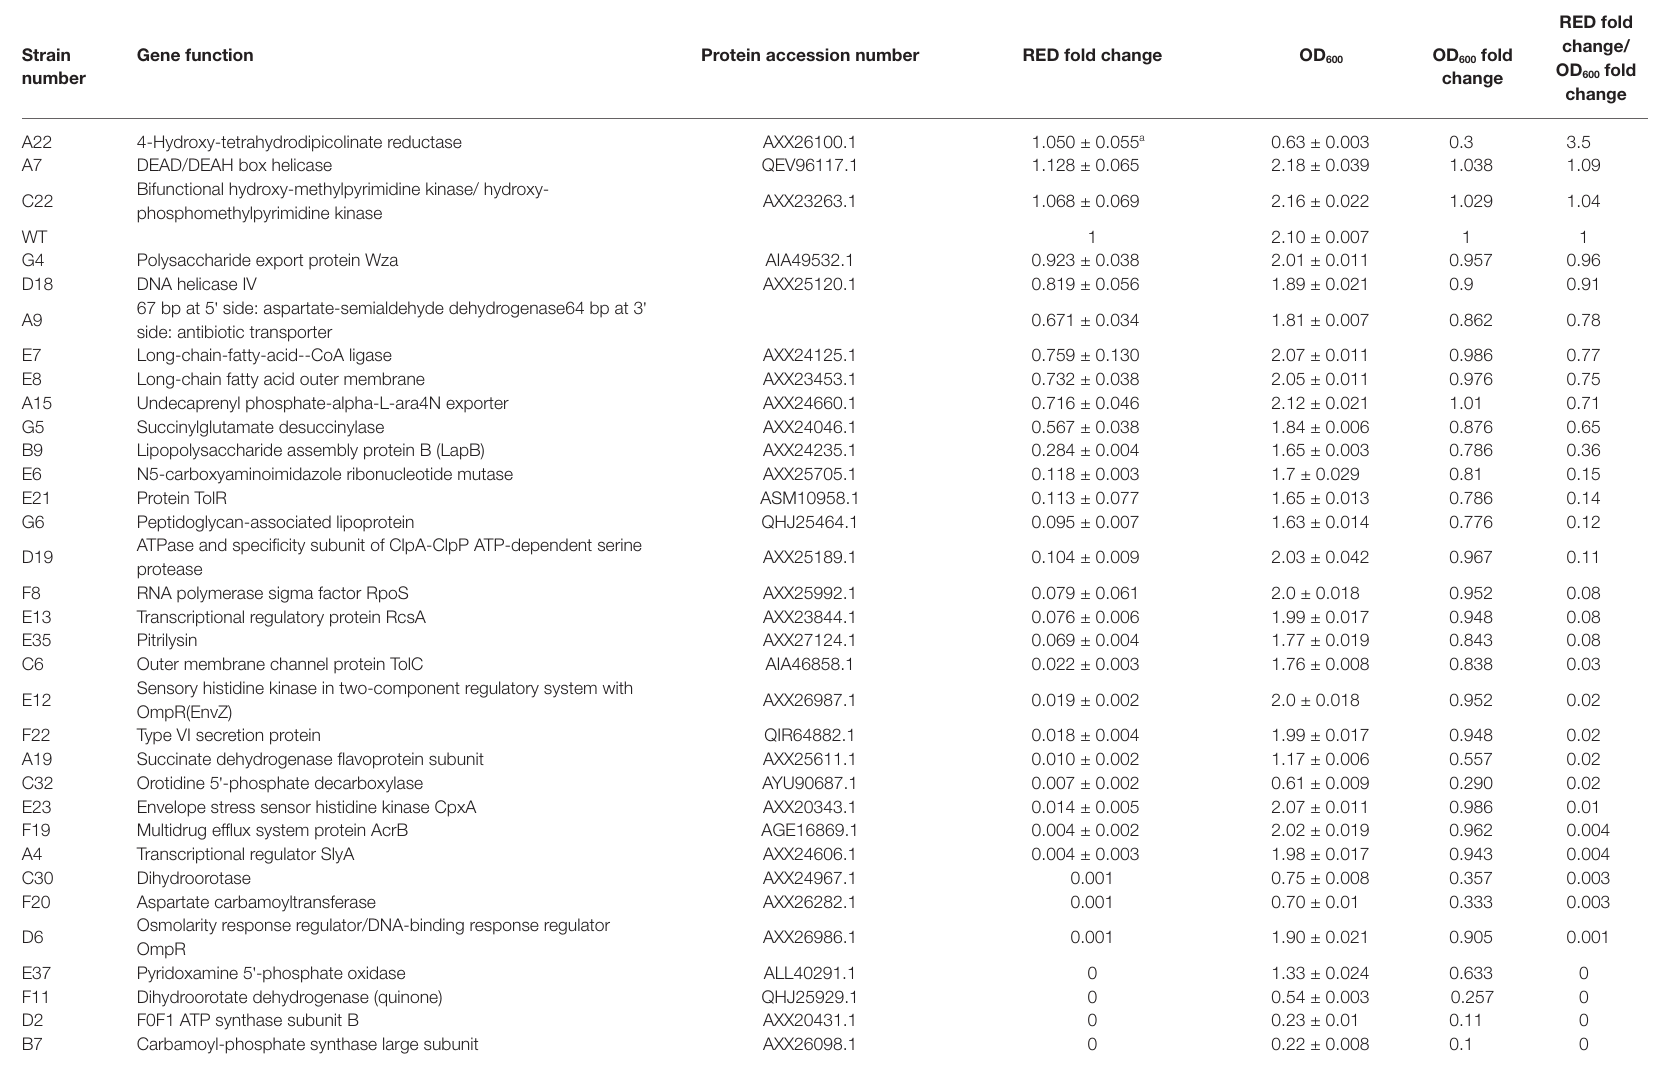
TABLE 3 | Characterization of the Tn5 mutants of Serratia marcescens FZSF02 with altered prodigiosin production.